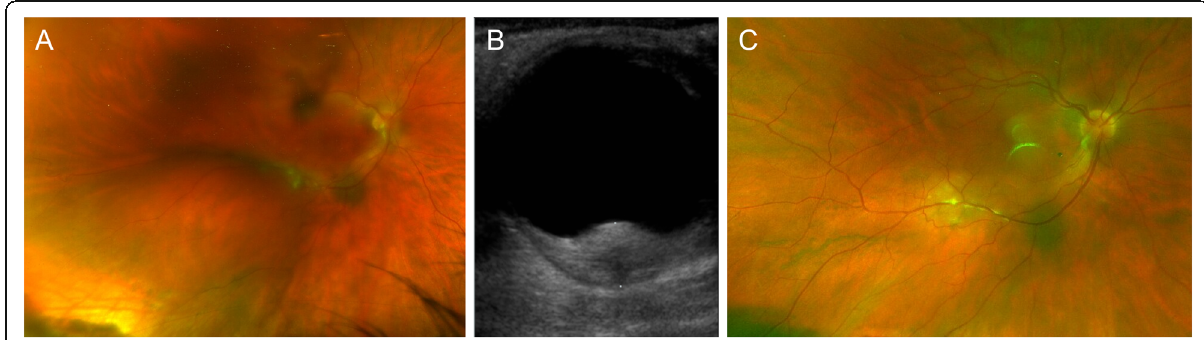
Fig. 2 Selected imaging findings in nodular posterior scleritis. ( A ) Pseudocolour fundus photograph of nodular posterior scleritis. ( B ) Corresponding B-scan ultrasound findings, showing gross thickening of the posterior coats (6.6mm) with increased echogenicity. An ab externo biopsy was negative for malignancy. ( C ) The nodular lesion resolved with topical and systemic steroids, and